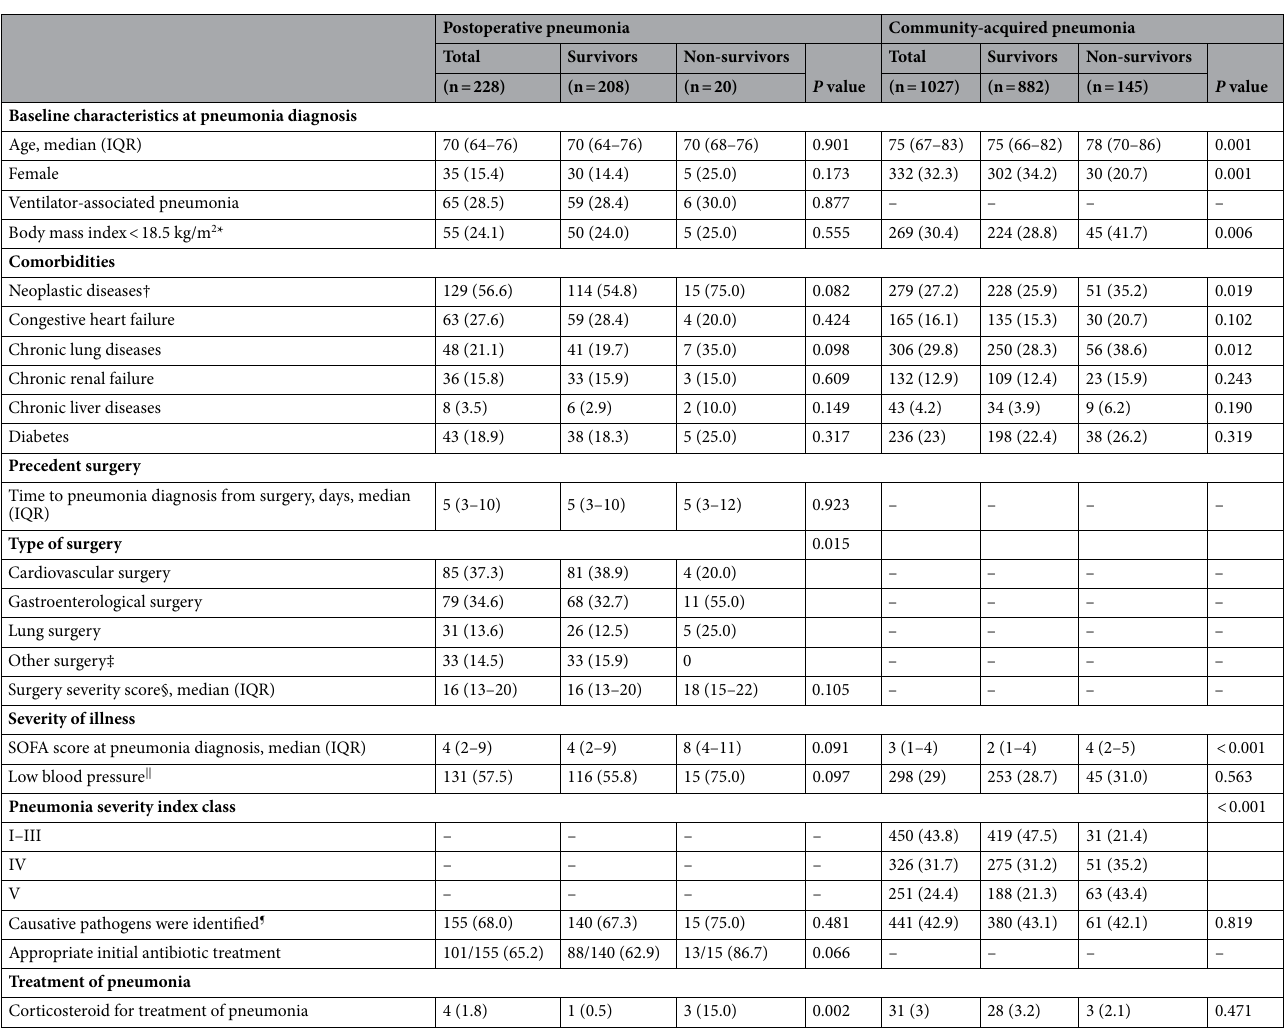
Table 1. Patient characteristics in postoperative pneumonia and community-acquired pneumonia. VAP entilator-associated pneumonia, BMI Body mass index, OSS Operative severity score, SOFA Sequential organ failure assessment, PSI Pneumonia severity index, IQR Interquartile range. Data are presented as n (%) unless indicated otherwise. *Body mass index was assessed in all patients with postoperative pneumonia, 886 patients (86.3%) with community-acquired pneumonia (778 survivors, and 108 non-survivors). † Neoplastic diseases were defined as any cancer that was active at the time of presentation or diagnosed within 5 years of presentation. ‡ Intracranial surgery (8 patients), head and neck surgery (16 patients), urological surgery (4 patients), orthopedic surgery (4 patients), and dermatological surgery (1 patients) were included. § Score was calculated using the physiological and operative severity score for the enumeration of the mortality and morbidity (POSSUM) scoring system. || Systolic blood pressure < 90 mmHg or diastolic blood pressure ≤ 60 mmHg or use of vasopressor. ¶ Major pathogens were as follows: Enterobacter spp. (39 (17.1%)), Pseudomonas aeruginosa (37 (16.2%)), and Klebsiella pneumoniae (28 (12.3%)) in POP, and Staphylococcus aureus (87 (8.5%)), K. pneumoniae (83 (8.1%)), and Streptococcus pneumoniae (70 (6.8%)) in